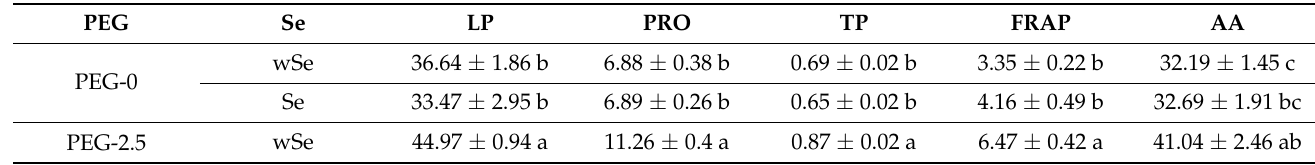
Table 3. Mean values ± standard error of mean for lipid peroxidation product (LP), proline content (PRO), total phenolic content (TP), total antioxidant activity (FRAP), and ascorbic acid (AA) over main effects PEG and Se. Different letters represent significance of differences at α = 0.05